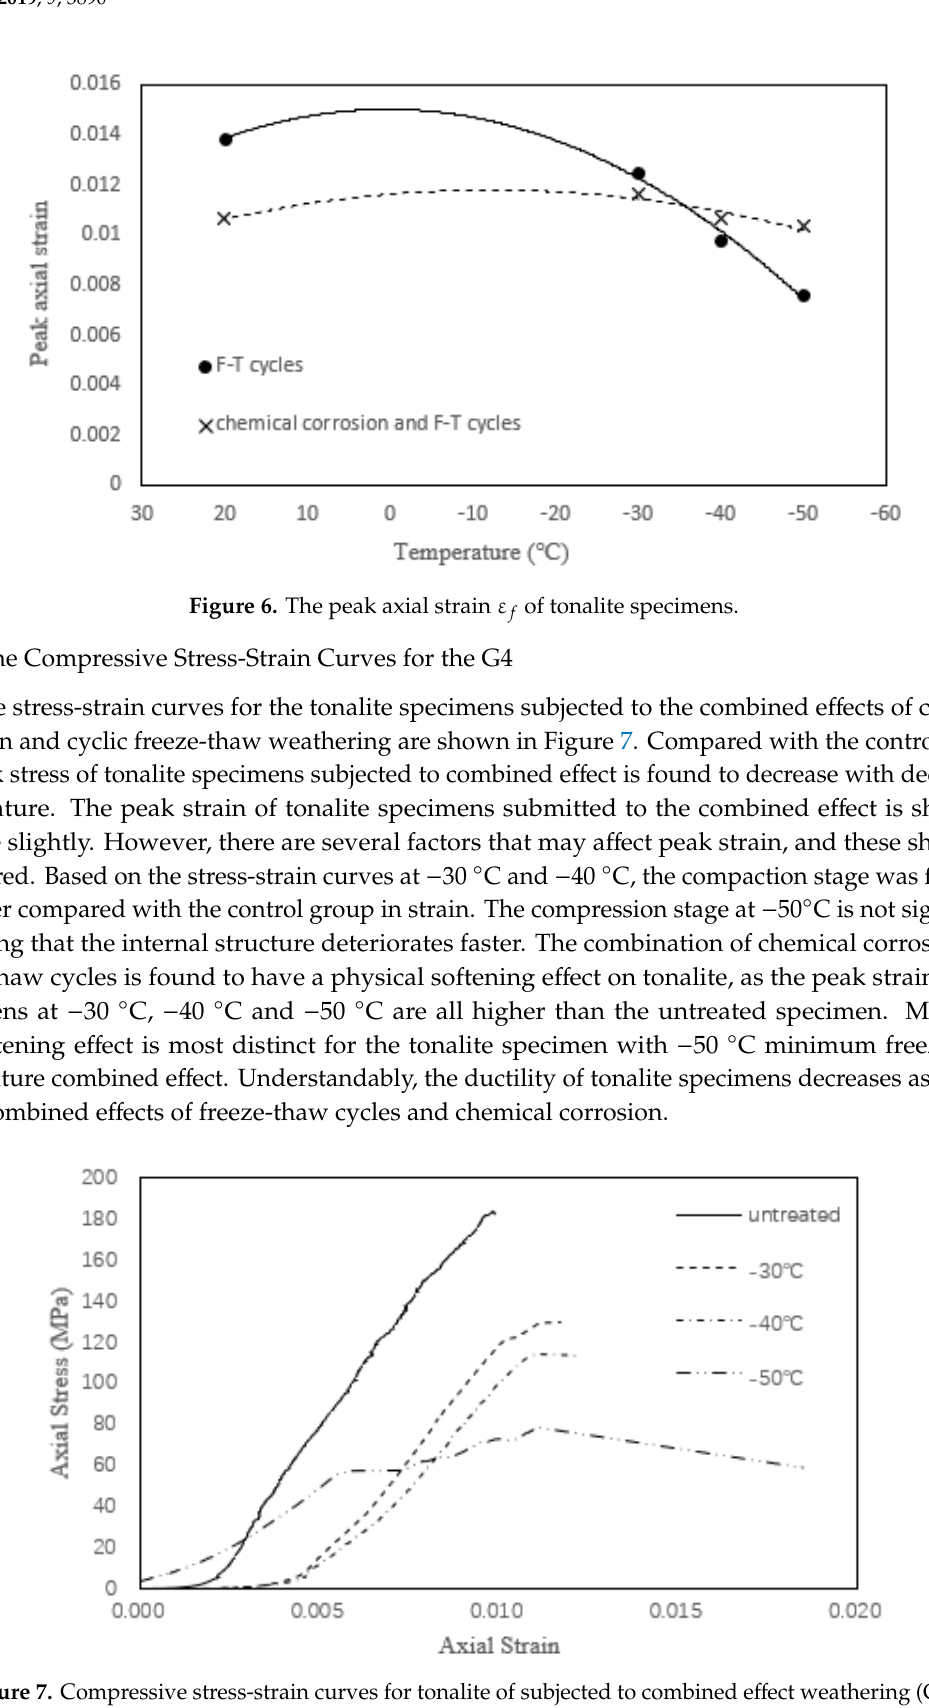
Figure 7. Compressive stress-strain curves for tonalite of subjected to combined e ff ect weathering (G4).